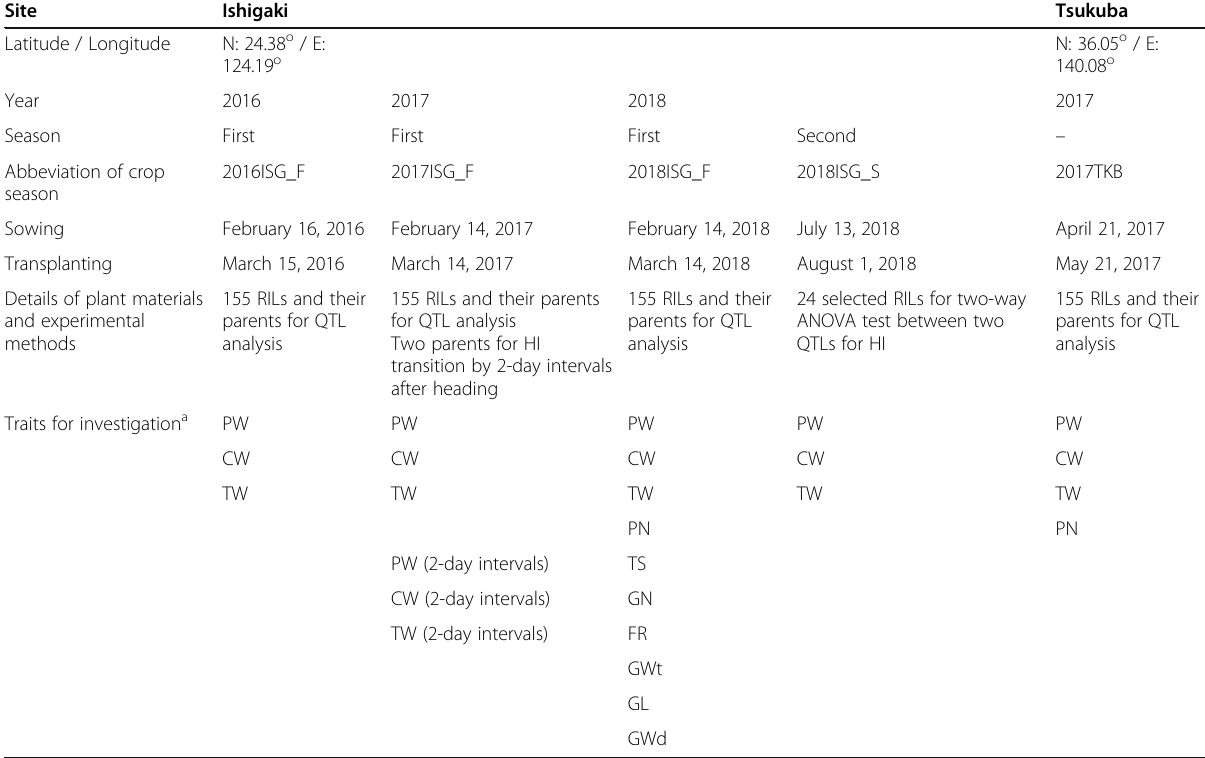
Table 1 Sowing date, transplanting date and investigation traits of each cropping season